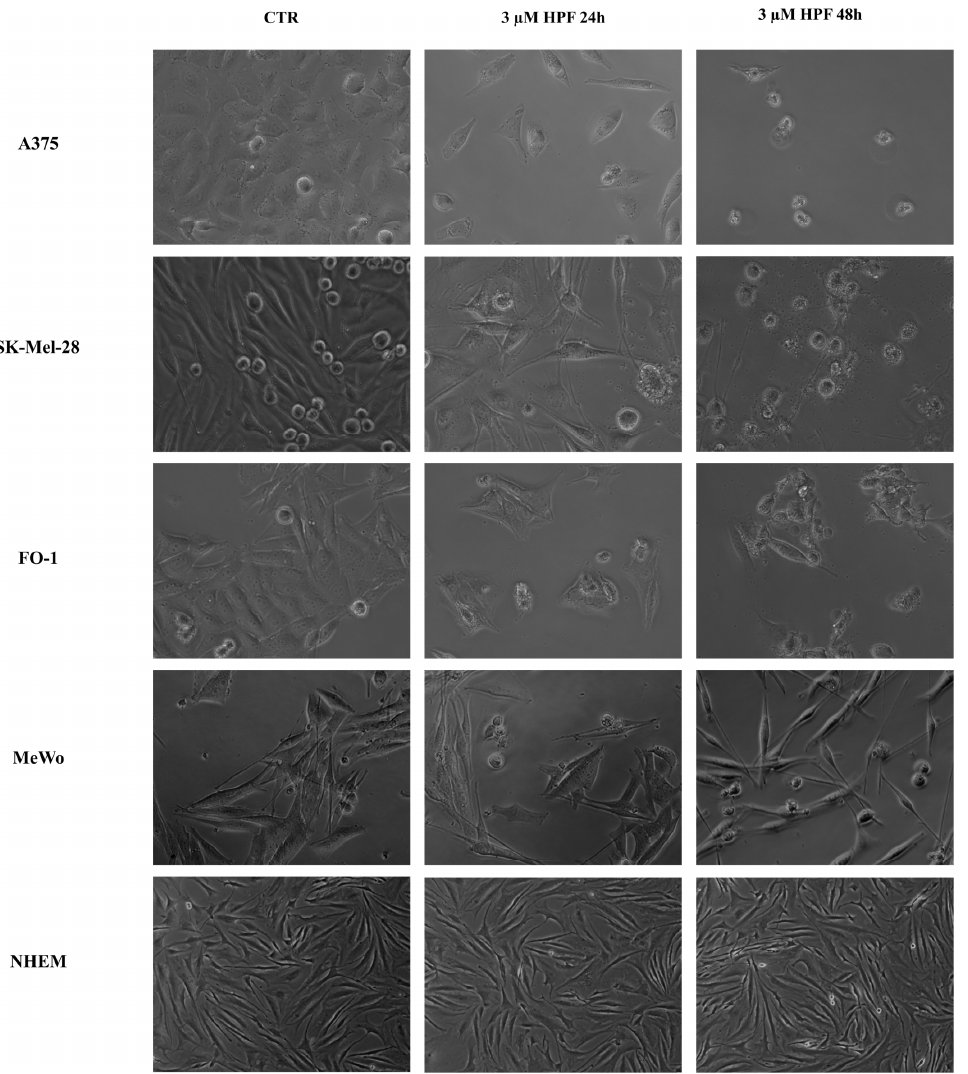
Figure 2. The images show melanoma cell morphological modifications after 24 and 48 h-treatment with 3 µM hyperforin. Representative images of A375, SK-Mel-28, FO-1 and MeWo melanoma cells and normal human epithelial melanocytes (NHEM), untreated (CTR) or treated with 3 µM hyperforin (HPF) for 24 and 48 hours. In melanoma cells but not in NHEM, HPF induces a time-dependent decrease in cell number and a change in cell shape from elongated to round with membrane blebbing. Images were captured at 20× magnification (5× magnification only for NHEM) with an inverted microscope (Axio Vert A1, Zeiss, Oberkochen, Germany).